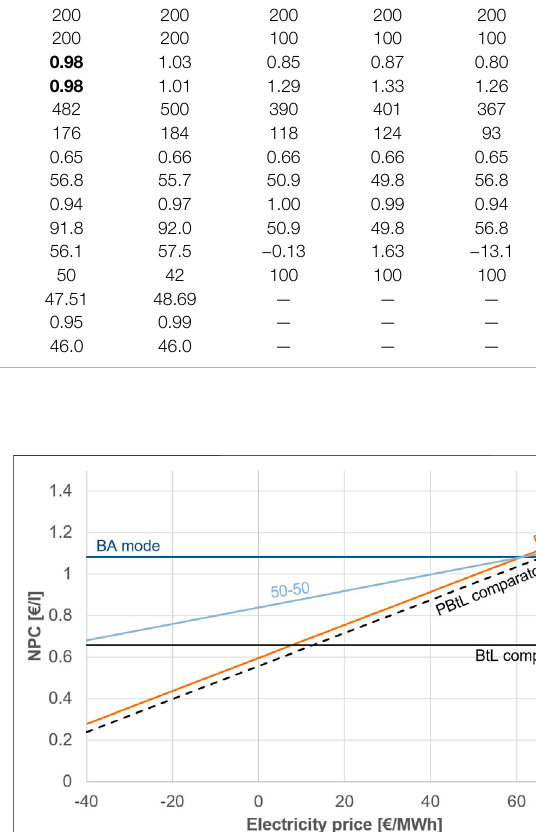
FIGURE 6 | Breakdown for net production cost NPC for the FT product in case 1.1 and 1.3 and corresponding fuel ( ▲ ) and carbon ef fi ciency ( ◆ ).